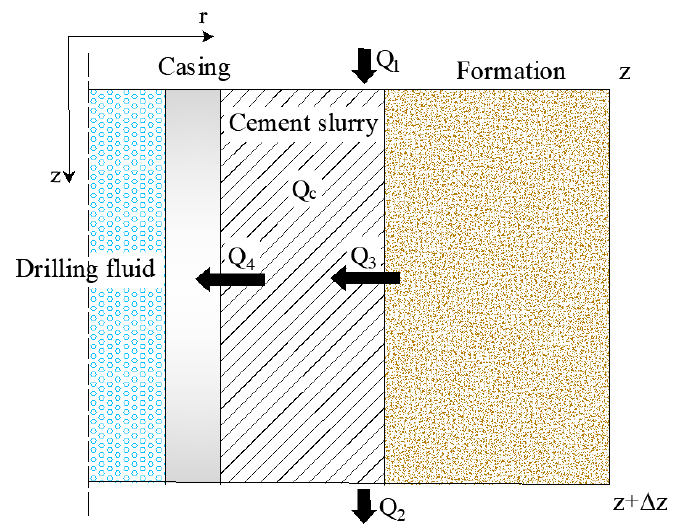
Figure 2. Schematic diagram of energy transfer in wellbore micro unit.